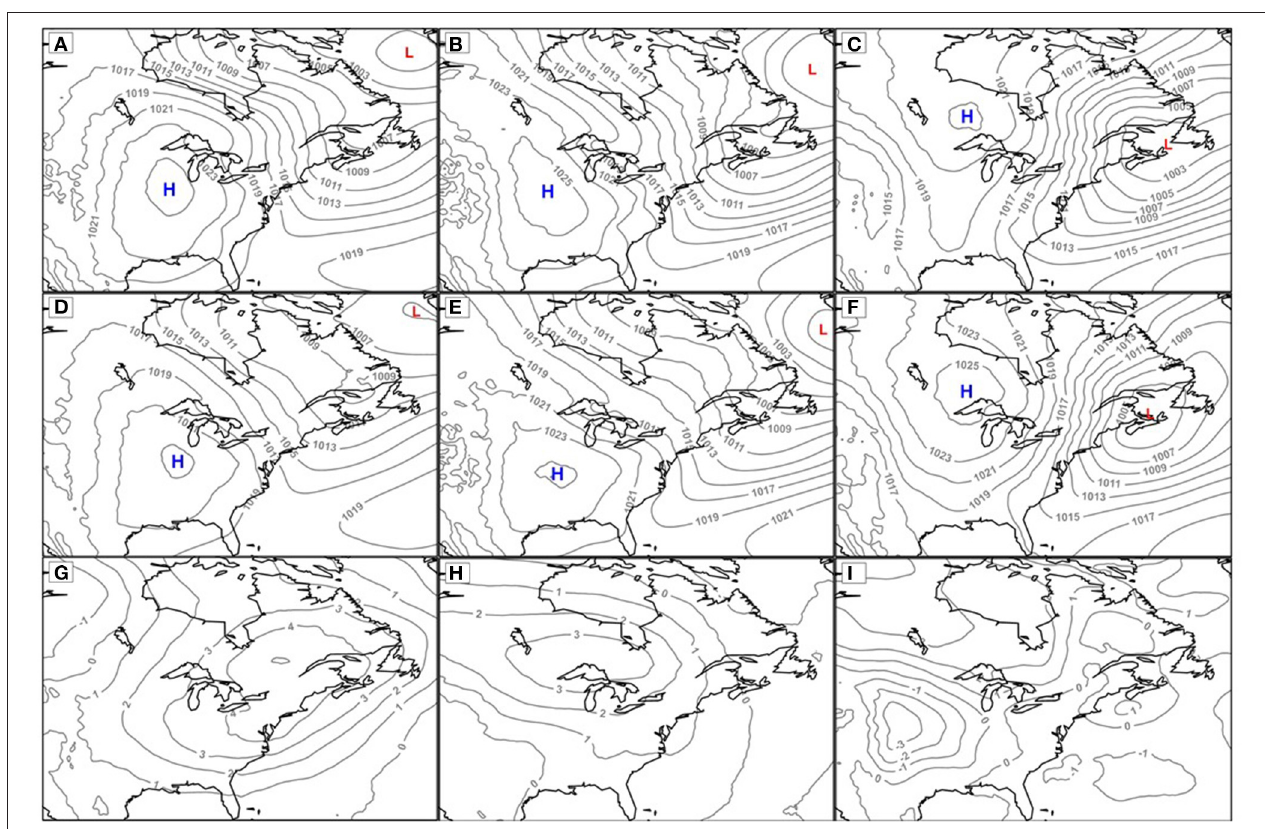
FIGURE 3 | For TSI-defined lake-effect days in early-season (left column), mid-season (middle column), and late-season (right column), mean sea-level pressure (hPa) for days corroborated by SSC data (A–C) , mean sea-level pressure for uncorroborated days (D–F) , and difference in mean 850 hPa air temperature ( ◦ C) on uncorroborated and corroborated days (uncorroborated minus corroborated) (G–I) , 1964–65 through 2014–15. Isobars are in 2-hPa intervals, and air temperature differences are in 1 ◦ C